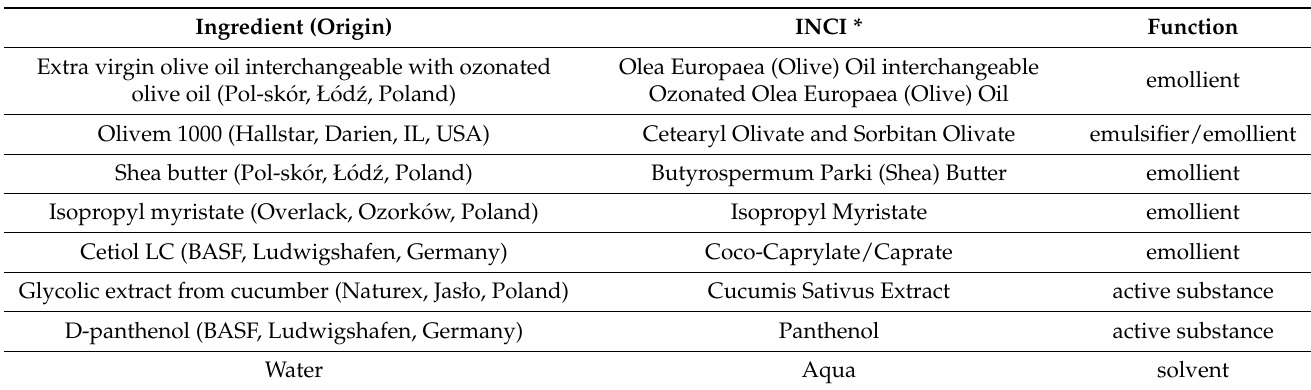
Table 6. Components of cosmetics